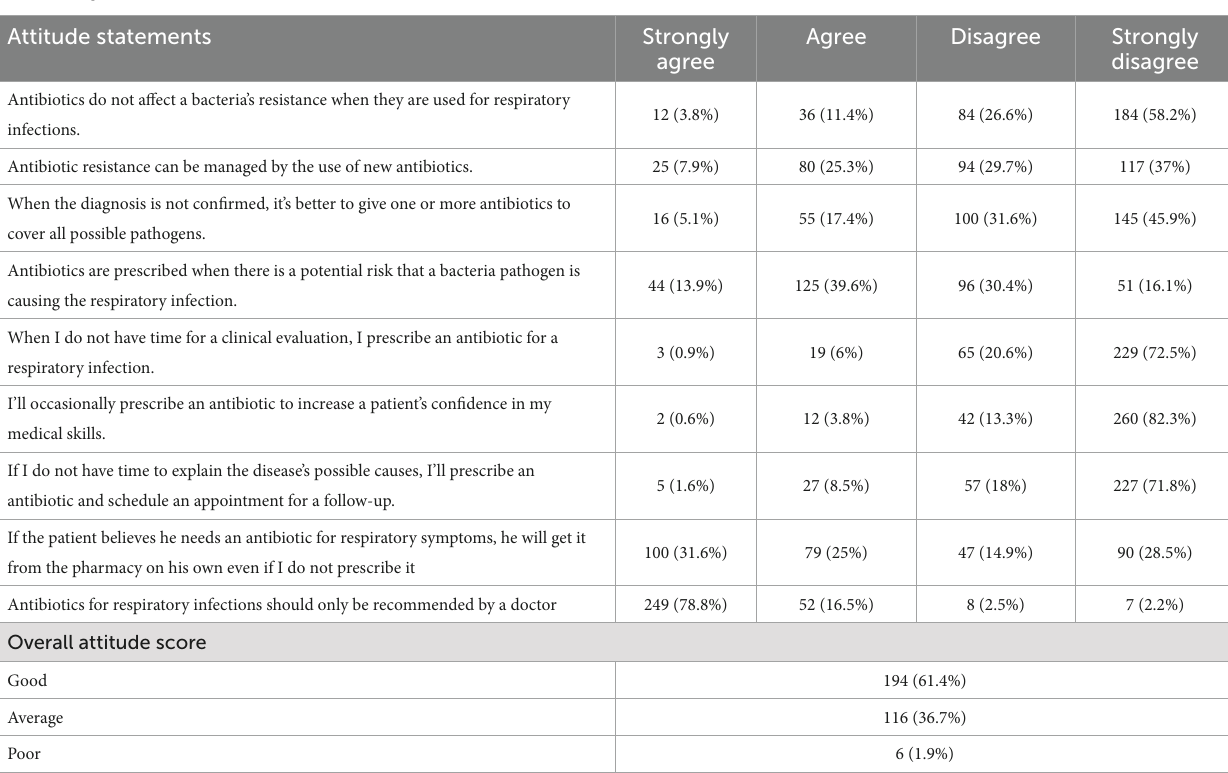
TABLE 3 Physicians’ attitudes about antibiotic